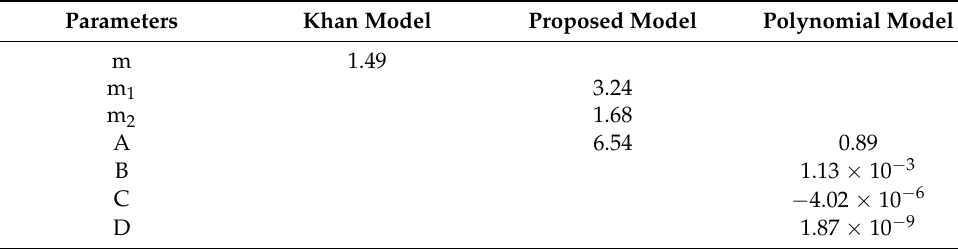
Table 6. Parameters of temperature models in this